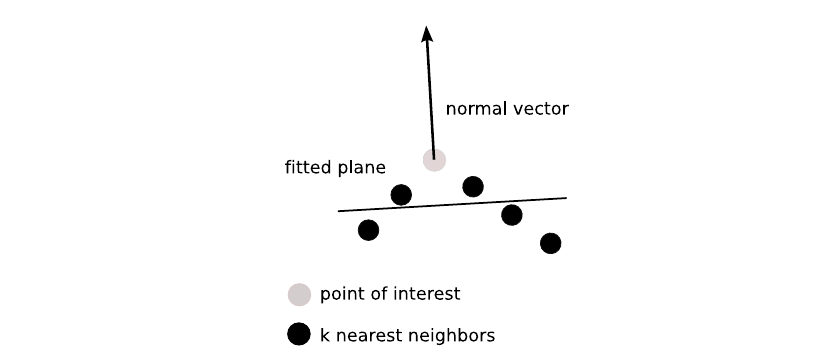
Figure 7. In many cases the normal vector on roof ridges differs beyond a defined angle threshold from those on the roof plane. Therefore, roof ridges often are not considered by the segmentation